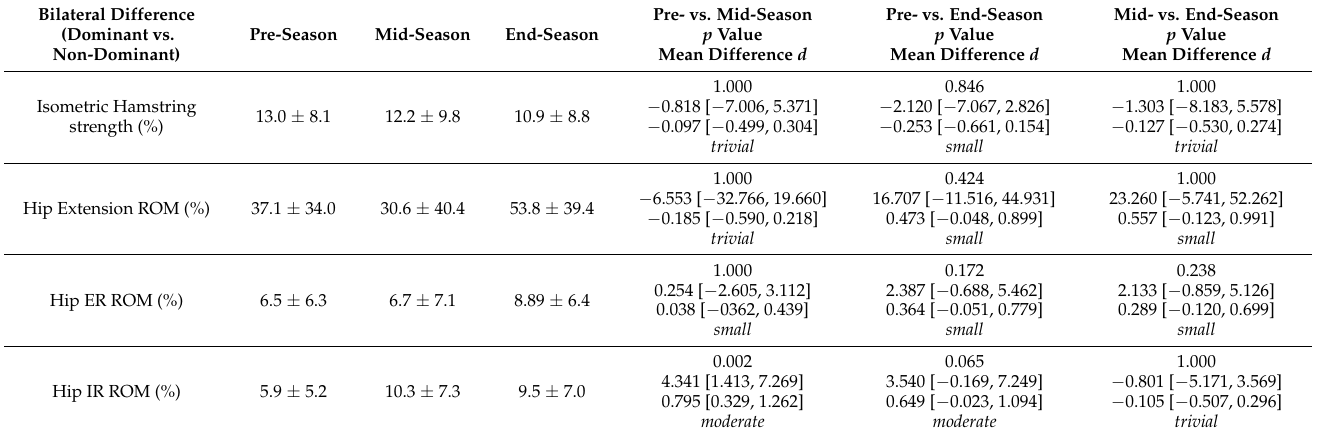
Table 3. Bilateral differences (dominant vs. non-dominant) for isometric hamstring muscle strength, passive hip flexion, extension, external rotation, internal rotation, and ankle dorsiflexion ROM assessed at pre-season, mid-season, and